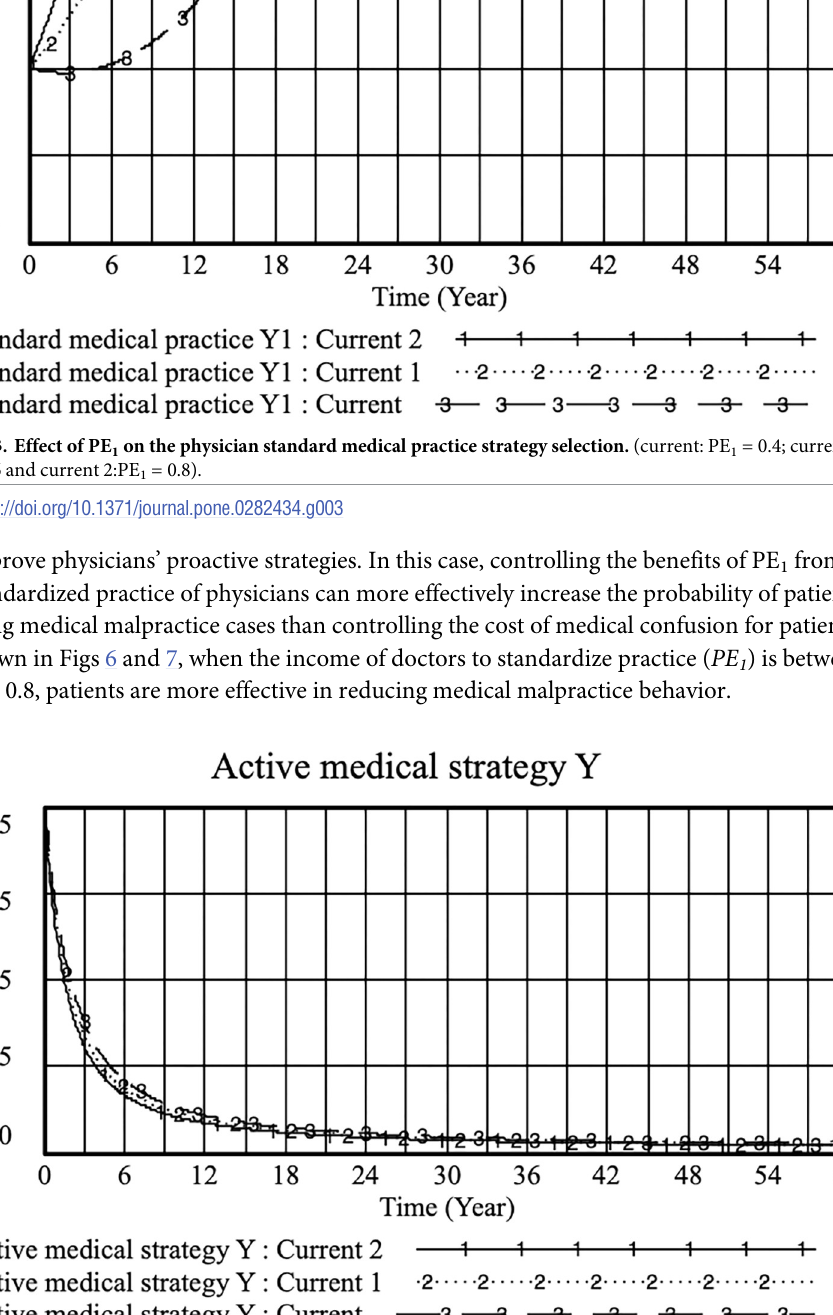
Fig 4. Effects of S 1 and S 2 on physicians’ positive strategy selection. (current: S 1 = 0.1, S 2 = 0.8; current 1: S 1 = 0.2, S 2 = 0.7and current 2:S 1 = 0.3, S 2 =